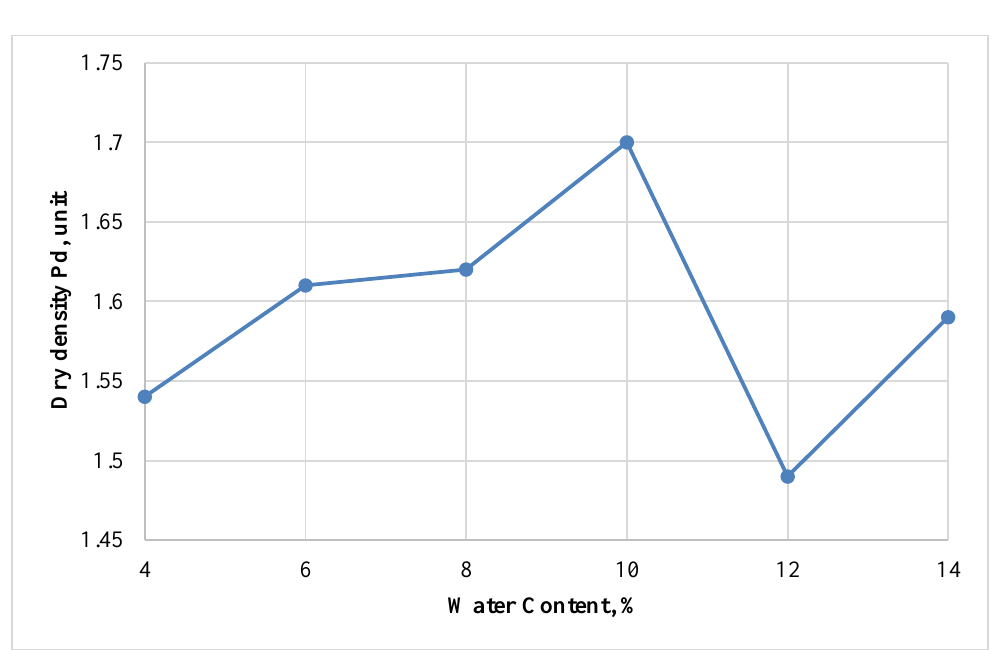
Fig. 1. Plot of dry density against water content (developed by the authors).